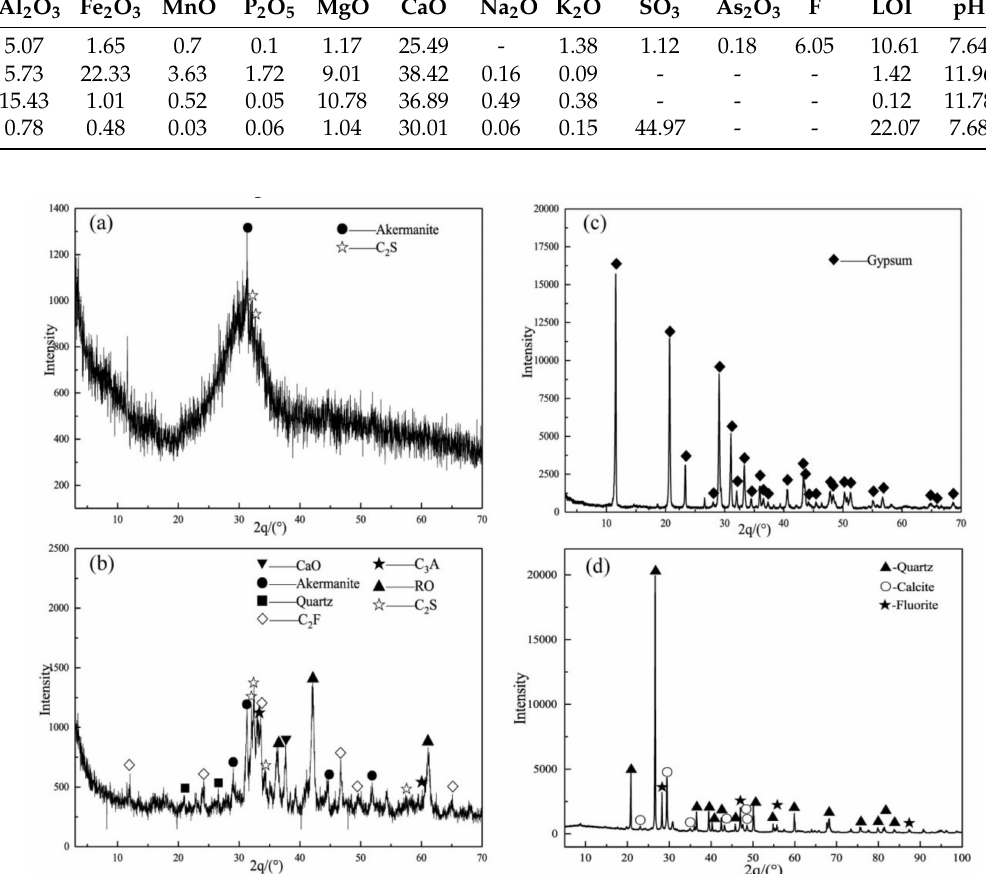
Figure 1. XRD patterns of the raw materials: ( a ) GGBFS; ( b ) SSP; ( c ) FGDG; ( d ) AT. Arsenic-containing tailings (AT) were collected from a closed lead and zinc tailings pond in Hechi Nandan, Guangxi (China). The main components of the tailings were quartz, calcite, and fluorite, of which the D 50 and D 90 particle sizes were 42 and188 µ m, respectively. According to the XANES analysis results of tailings in the same tailings pond in the literature [31], the main forms of arsenic (As) in tailings are arsenopyrite (66 wt.%), arsenate (17 wt.%) and arsenite (17 wt.%). The total As concentration of the tailings was 2098 mg/kg as determined with an Agilent 7500a ICP-MS system (Agilent Technologies, Santa Clara, CA, USA) after aqua regia digestion (concentrated HNO 3 and HCl in a ratio of 1:3 ( v / v )) according to the Chinese standard method HJ